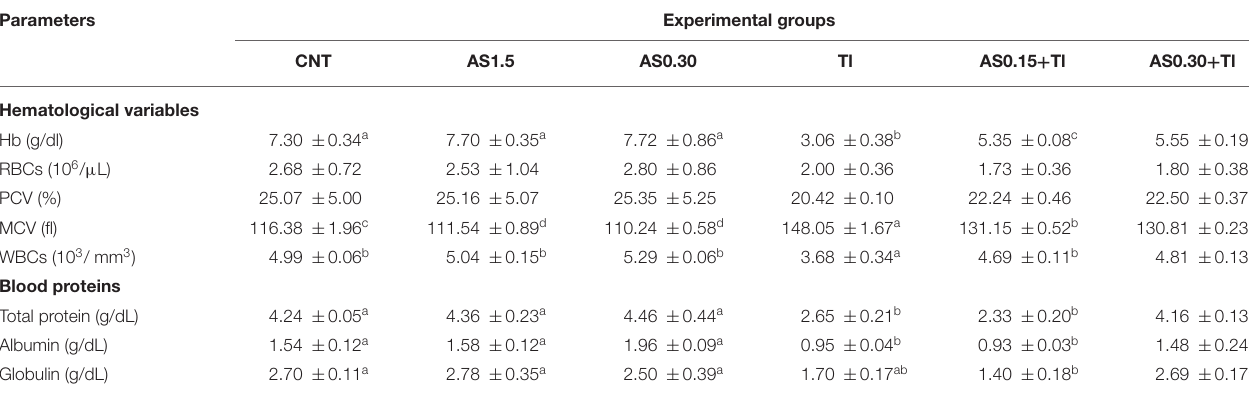
TABLE 3 | Effect of dietary supplementation with Astragalus membranaceus polysaccharides (AS) levels (0.15 and 0.30%) and/or exposure to sublethal thallium (Tl) toxicity [1/10th lethal concentration 50 (LC50); 41.9 µ g/l] for 8 weeks on the hematological variables and blood protein profile of Nile tilapia. Parameters